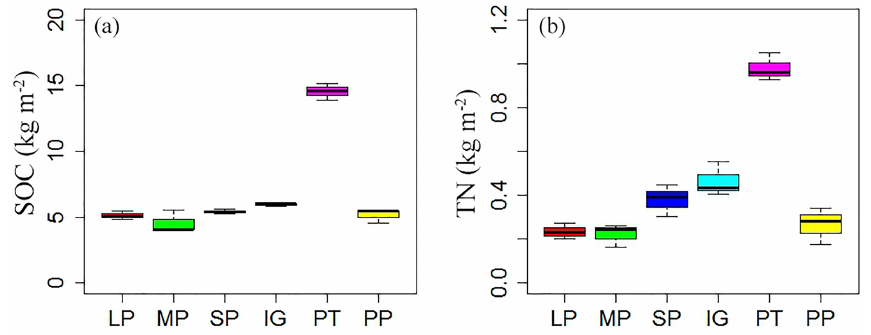
Figure 7. Soil organic carbon (SOC; a ) and total nitrogen (TN; b ) density of different surface types: (1) large bald patch (LP), (2) medium bald patch (MP), (3) small bald patch (SP), (4) intact grassland patch (IG), (5) above pika tunnel (PT) and (6) old pika pile (PP).